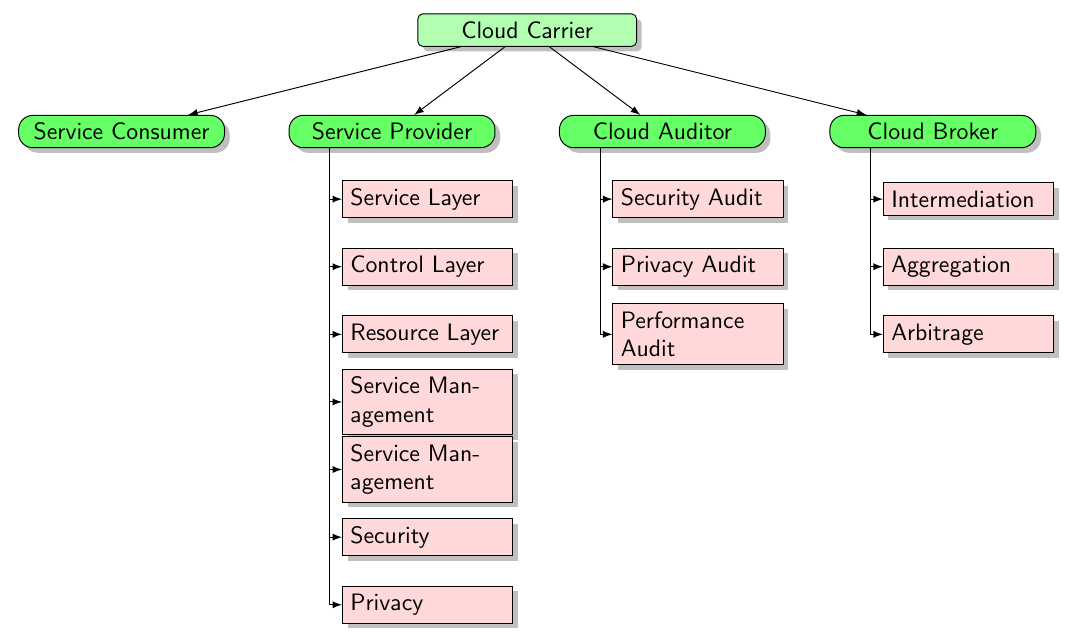
Figure 2. Cloud computing architecture.